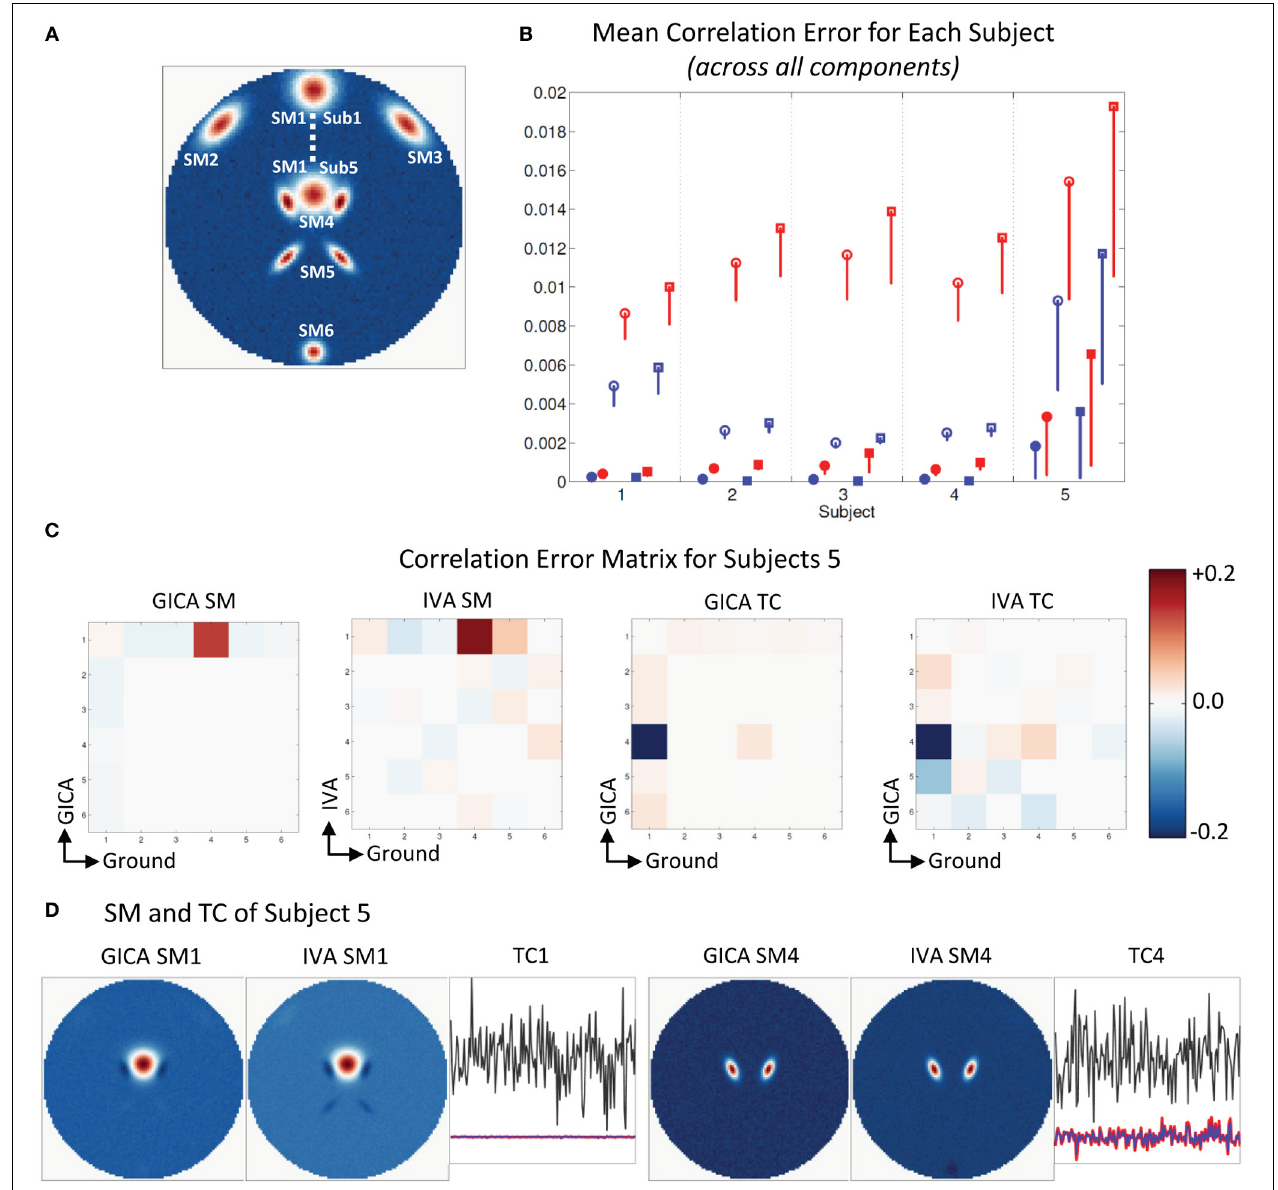
FIGURE 4 | Results of Experiment 2e: Estimation when components overlapspatially.(A) GroundtruthSMs:SM2toSM6forallsubjectsareatthe same location, SM1 of Subjects 1 and 5 are presented, SM1 for Subjects 2–4 areequallydistributedbetweenlocationsofSubjects1and5.InSubject5,SM1 slightly overlaps with SM4. (B) Mean correlation errors across all components, presented for each subject separately. Mean errors are in blue for GICA and in redforIVA.Diagonalelementsofthecorrelationerrormatrixareinfilledshapes and non-diagonal in unfilled shapes. SMs are presented in circles and TCs in squares (see “Definition of Result Evaluation Parameters” section for their definitions):correlationerrorsaresmallinSubjects1–4,largeerrorsinSubject5